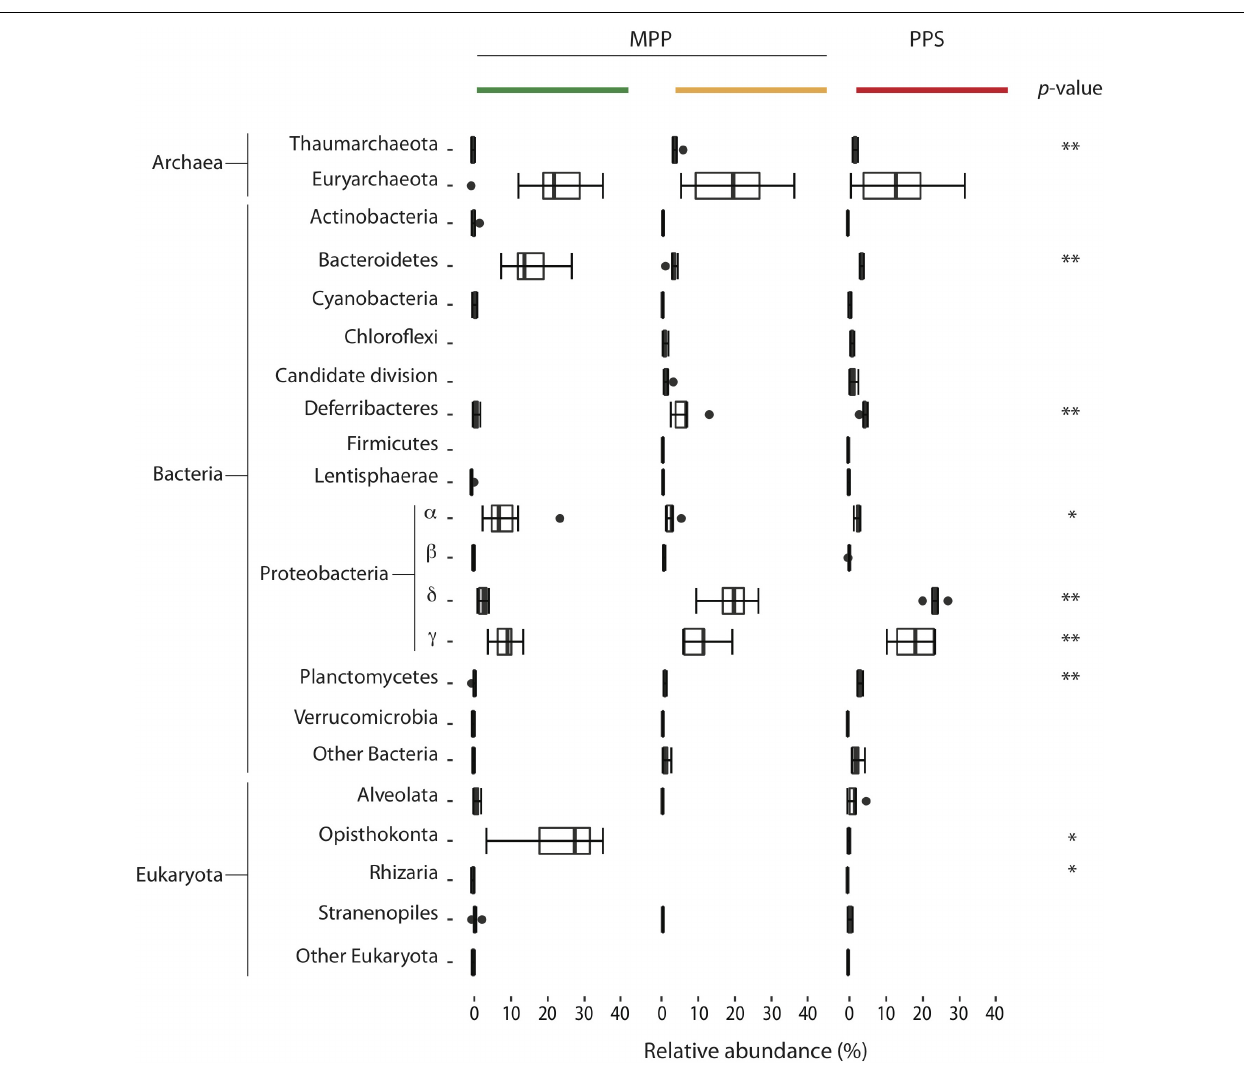
FIGURE 4 | Community shifts occurred among and within filter combinations for PPS in situ 0.4 µ m (red), and MPP on-ship 0.4 µ m (green), and 0.22 µ m with in-line 0.4 µ m prefilters (yellow). The size of each box represents the average of the percentage of relative abundance throughout the water column over this period. For both plots, extended dashed lines (whiskers) represent at the base the lower and upper quartiles (25 and 75%) and at the end the minimum and maximum values encountered. The middle line represents the median. p -Values for significant relative abundance shifts among filter groups are depicted as ∗ p < 0.01 and ∗∗ p < 0.001 aside corresponding